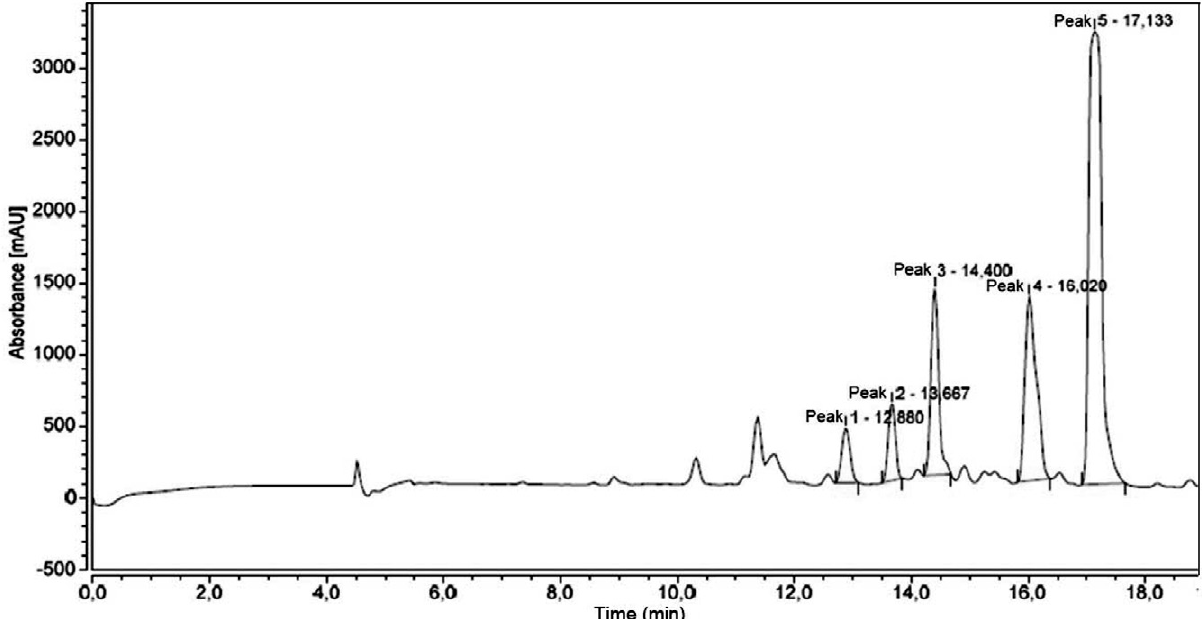
Figure 1. Chromatogram of Phomopsis species dichloromethane dry extract dissolved in mixture of methanol and water 50:50 (v/v) from semi-pre- parative HPLC analysis Table 1. 1 H (400 MHz) and 13 C (100 MHz) spectral analysis of compounds 325-3 and 325-5 Compound 325-3 Compound